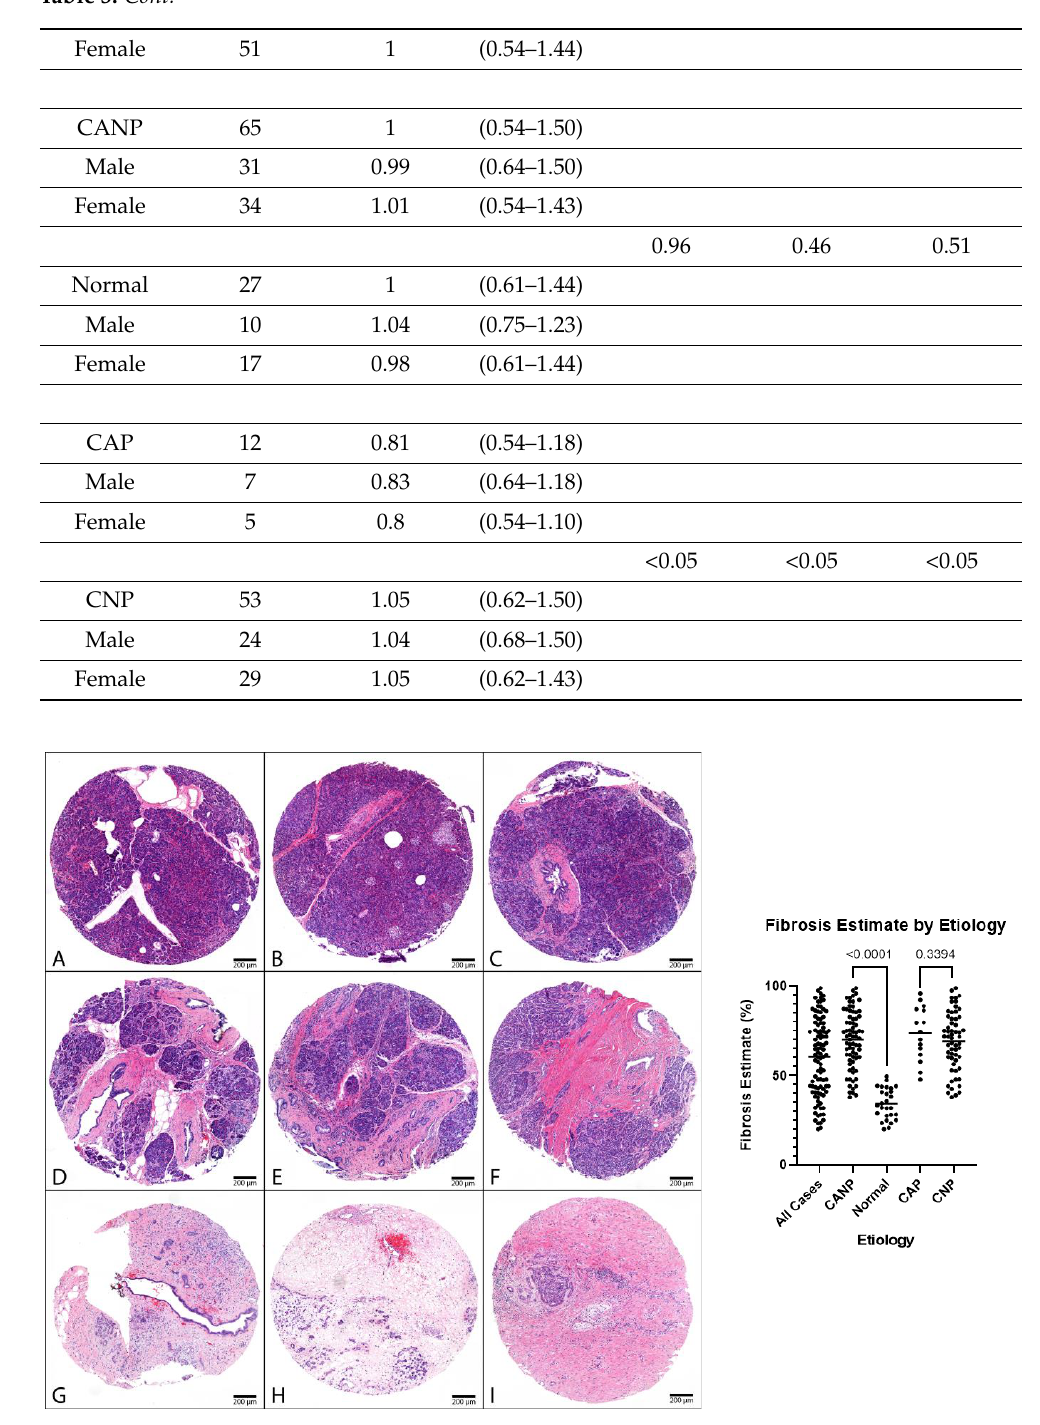
Figure 1. Representative cohort cases, H&E. Left: ( A – C ) Representative normal pancreatic tissue (NPT) with fibrosis estimates of 23%, 35%, and 44%, respectively (NPT cohort average of 34%). ( D – F ) Representative chronic pancreatitis tissue with fibrosis estimates of 61%, 65%, and 70%, respec- tively. ( G – I ) Representative chronic pancreatitis tissues with fibrosis estimates of 92%, 95%, and 96%, respectively. Panels ( D , F , H ) are cases of CNP (CNP cohort average of 69%). Panels ( E , G , I ) are cases of CAP (CAP cohort average of 74%): 40× magnification. ( Right ): Dot plot of fibrosis estimates, combined genders, with p -values displayed. H&E, hematoxylin and eosin.